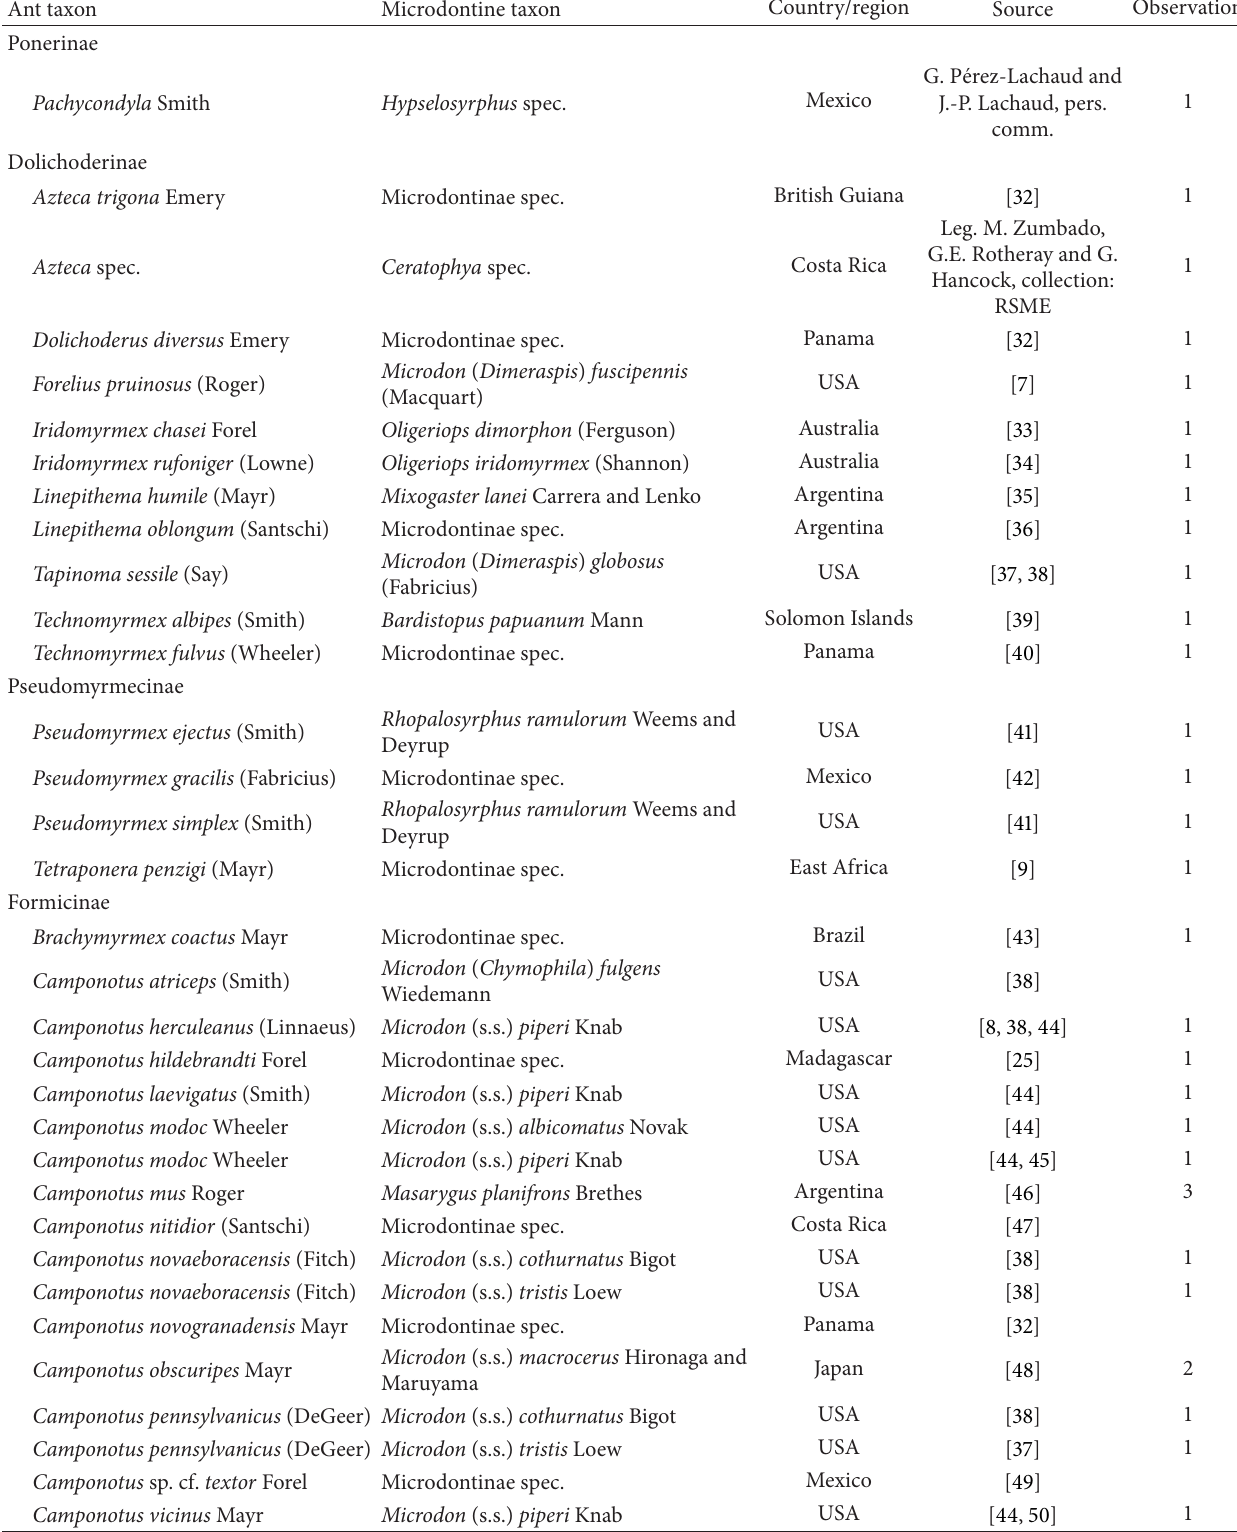
Table 1: List of all known records of immature stages of Microdontinae found in association with ants. The records are first sorted by ant subfamily, then alphabetically by ant genus and species. Observation: 1: larva(e) or pupa(e) found in nest; 2: freshly emerged specimens found near nest; 3: adult female(s) observed ovipositing near nest entrance; 4: adult specimens observed near